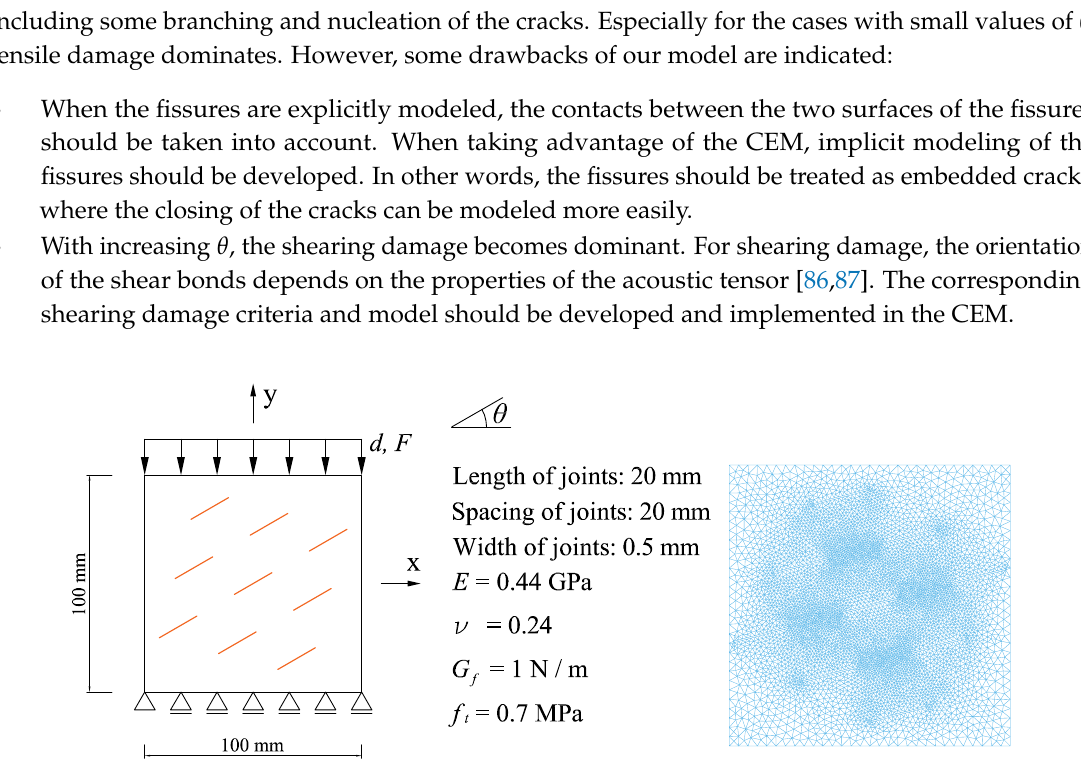
Figure 17. Rock-like materials with nine parallel fissures: the model, material, and meshes.